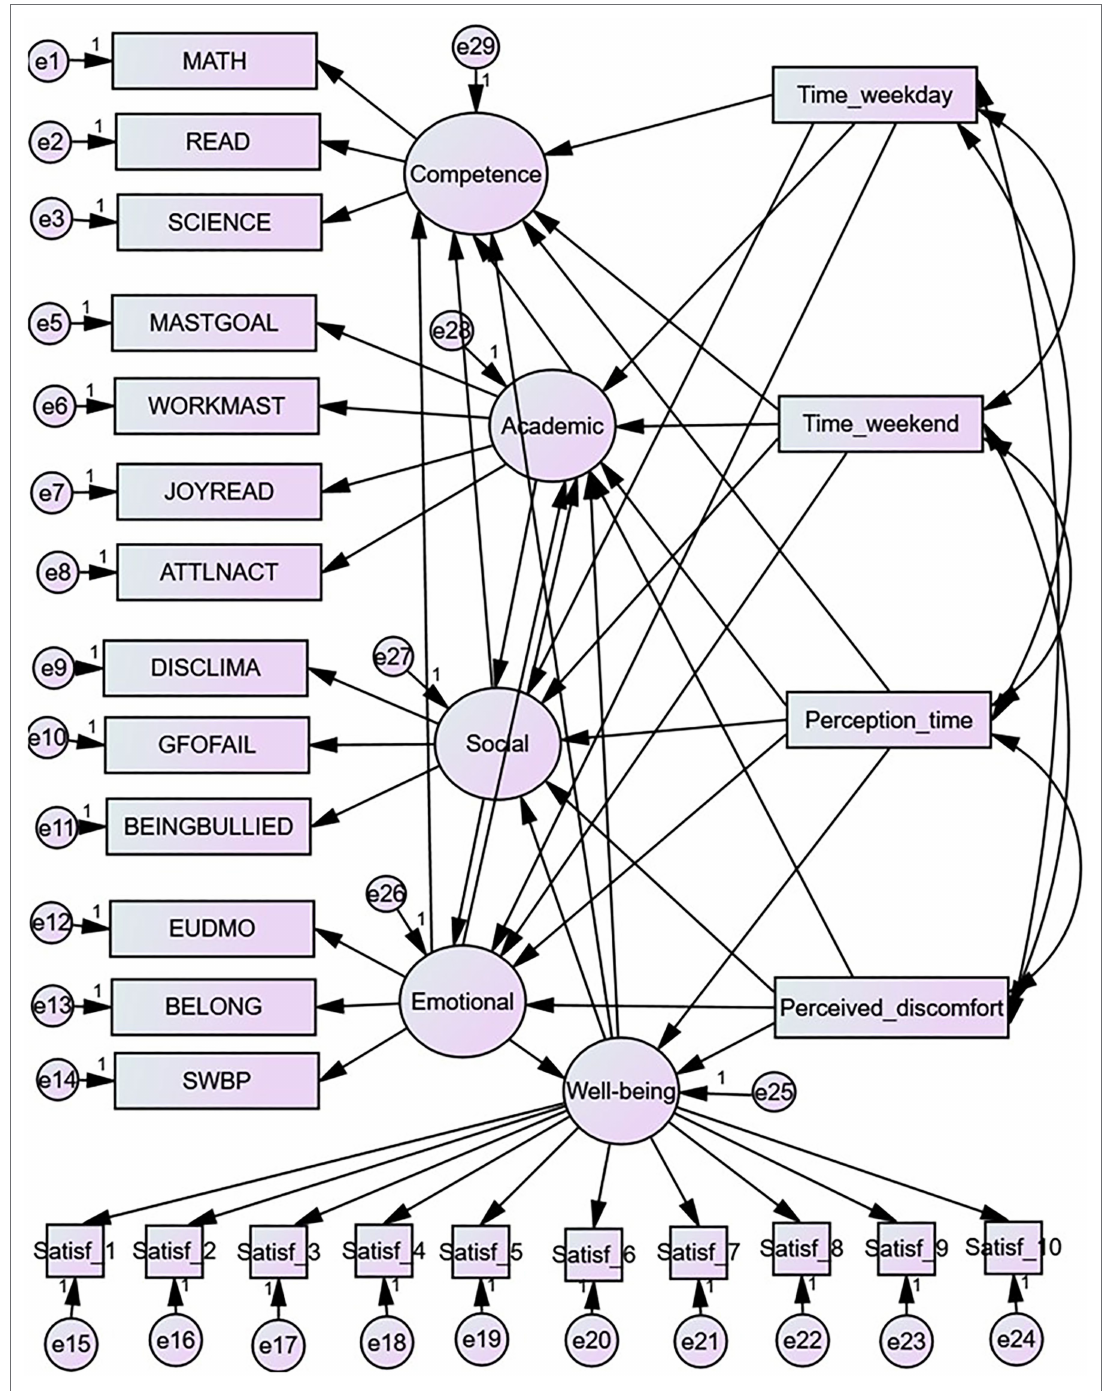
FIGURE 1 | Model and relationship between observed variables and latent